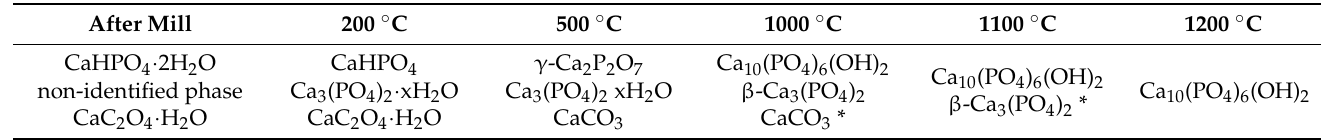
Table 1. Phase composition of powder mixtures and ceramic